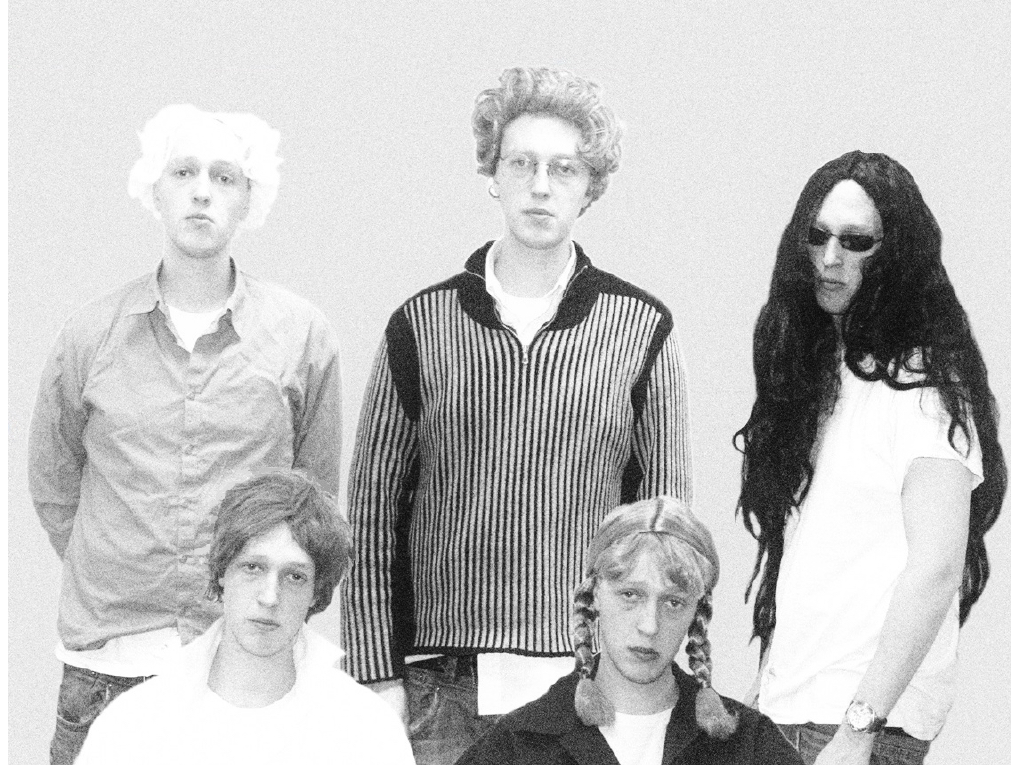
Figure 7: Ultrapopart,